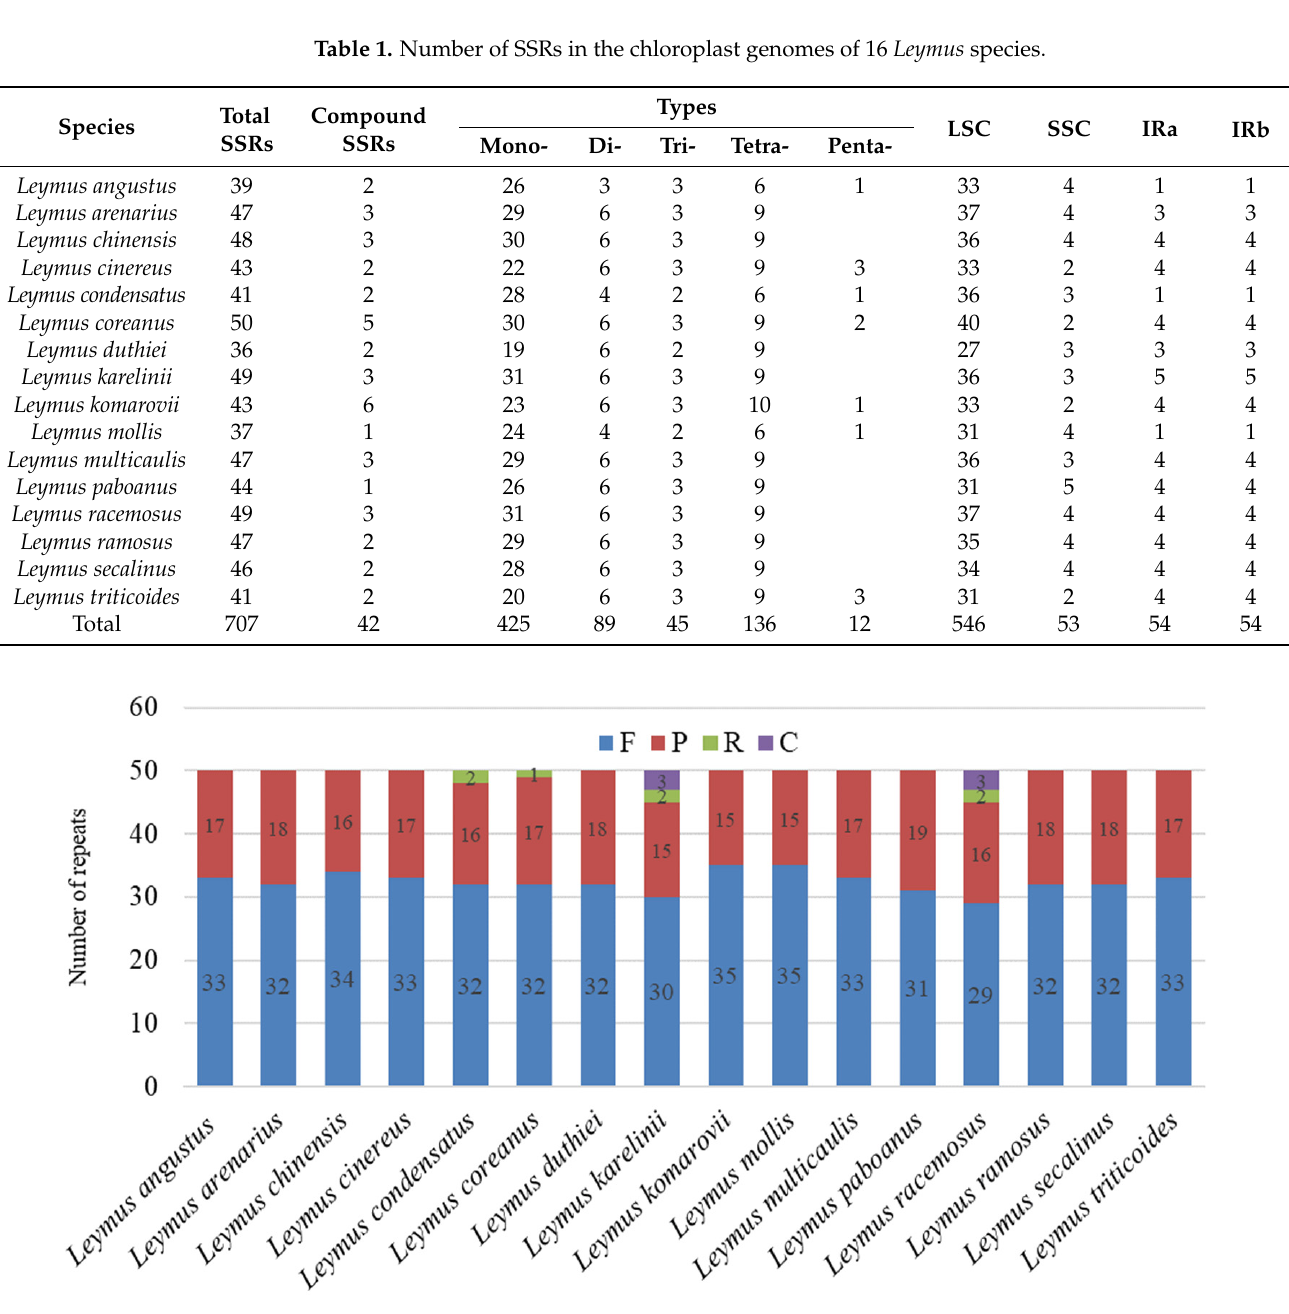
Figure 2. The number of the four types of repeats identified in the 16 Leymus cp genomes. F, P, R, and C represent forward, palindromic, reverse, and complementary repeats, respectively.